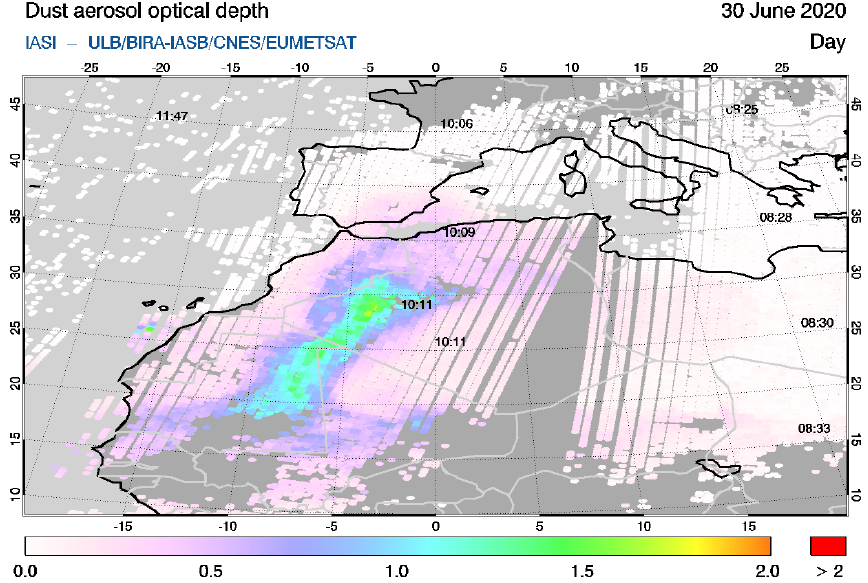
Figure 9. Saharan dust AOD observed by IASI-C on 30 June